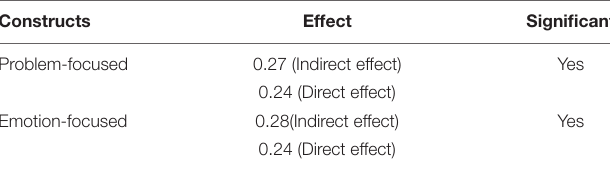
TABLE 7 | Assessment of mediating effect (bootstrapping